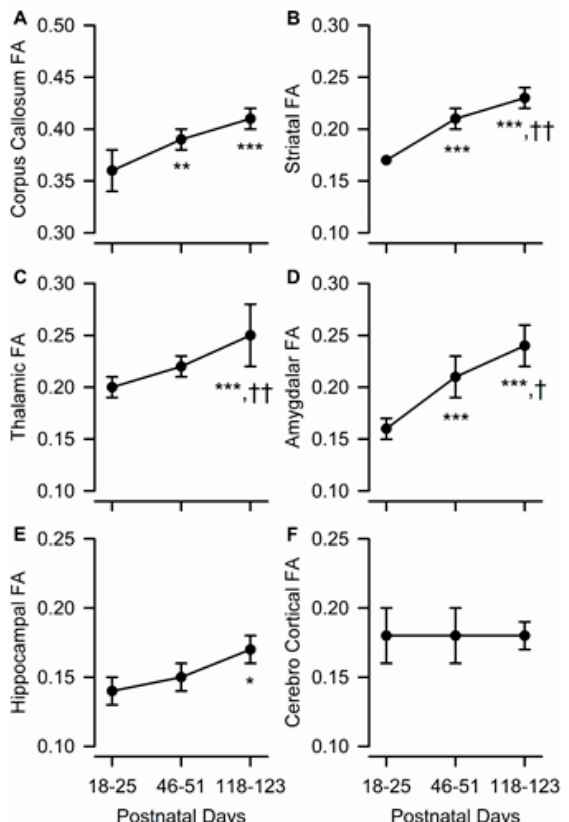
Figure 3. Age dependence of fractional anisotropy (FA) in different ROIs of the male guinea pig brain. Graphs illustrate the age dependence of FA in the corpus callosum ( A ), striatum ( B ), thalamus ( C ), amygdala ( D ), hippocampus ( E ), and cerebral cortex ( F ) in the brain of male guinea pigs. Symbols and error bars represent mean and SD of results obtained from six guinea pigs, examined longitudinally at PND 18-25, PND 46-51, and PND 118-123. Whenever ANOVA revealed a significant effect of age on a given parameter, the Tukey post-hoc test was used for multi-group comparisons. Asterisks and daggers are used for comparison with data obtained at PND 18-25 and PND 46-51, respectively. *, p < 0.05, **, p < 0.01, ***, p < 0.001; †, p < 0.05; ††, p < 0.01.